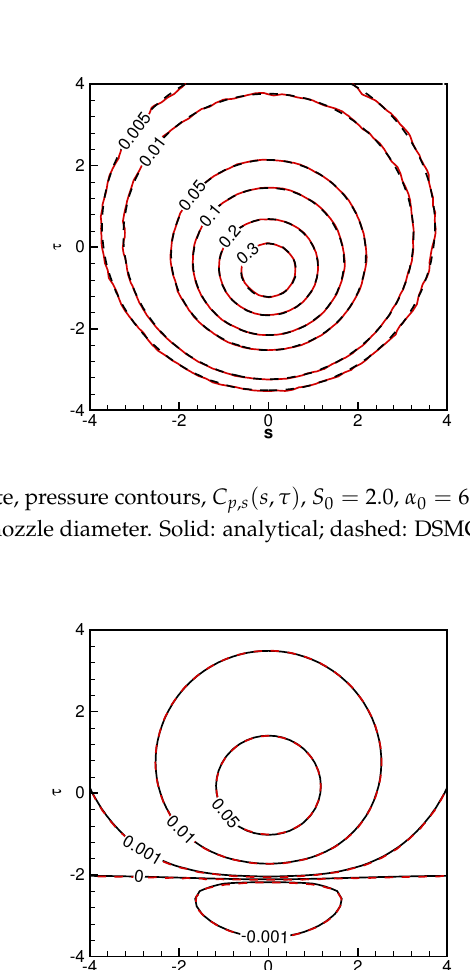
Figure 19. Diffuse plate, friction coefficient, C f are normalized by the nozzle diameter. Solid: analytical; dashed: